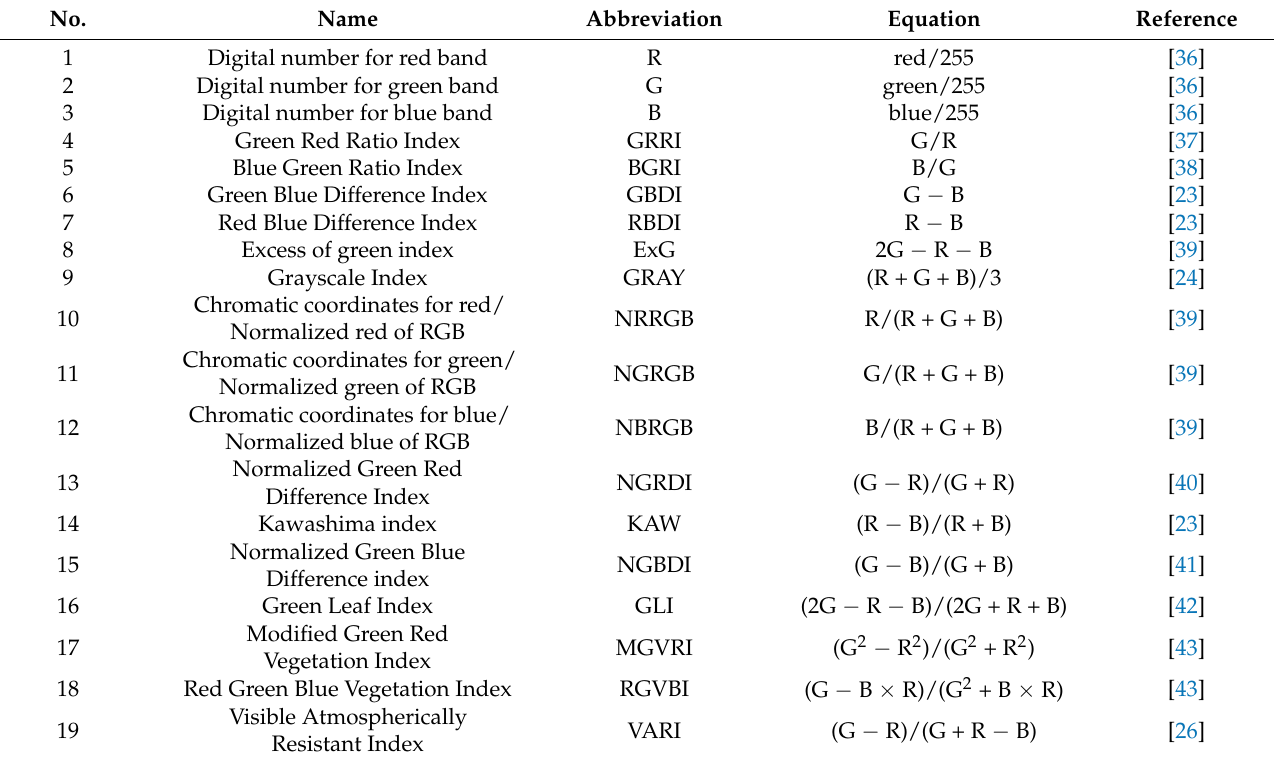
Table 3. Estimated vegetation indices used in the